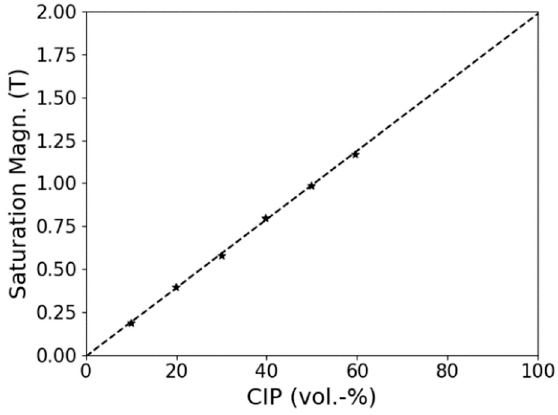
Figure 8. The saturation magnetization in relation to the CIP content and extrapolation of the re- sults to 100% carbonyl iron.